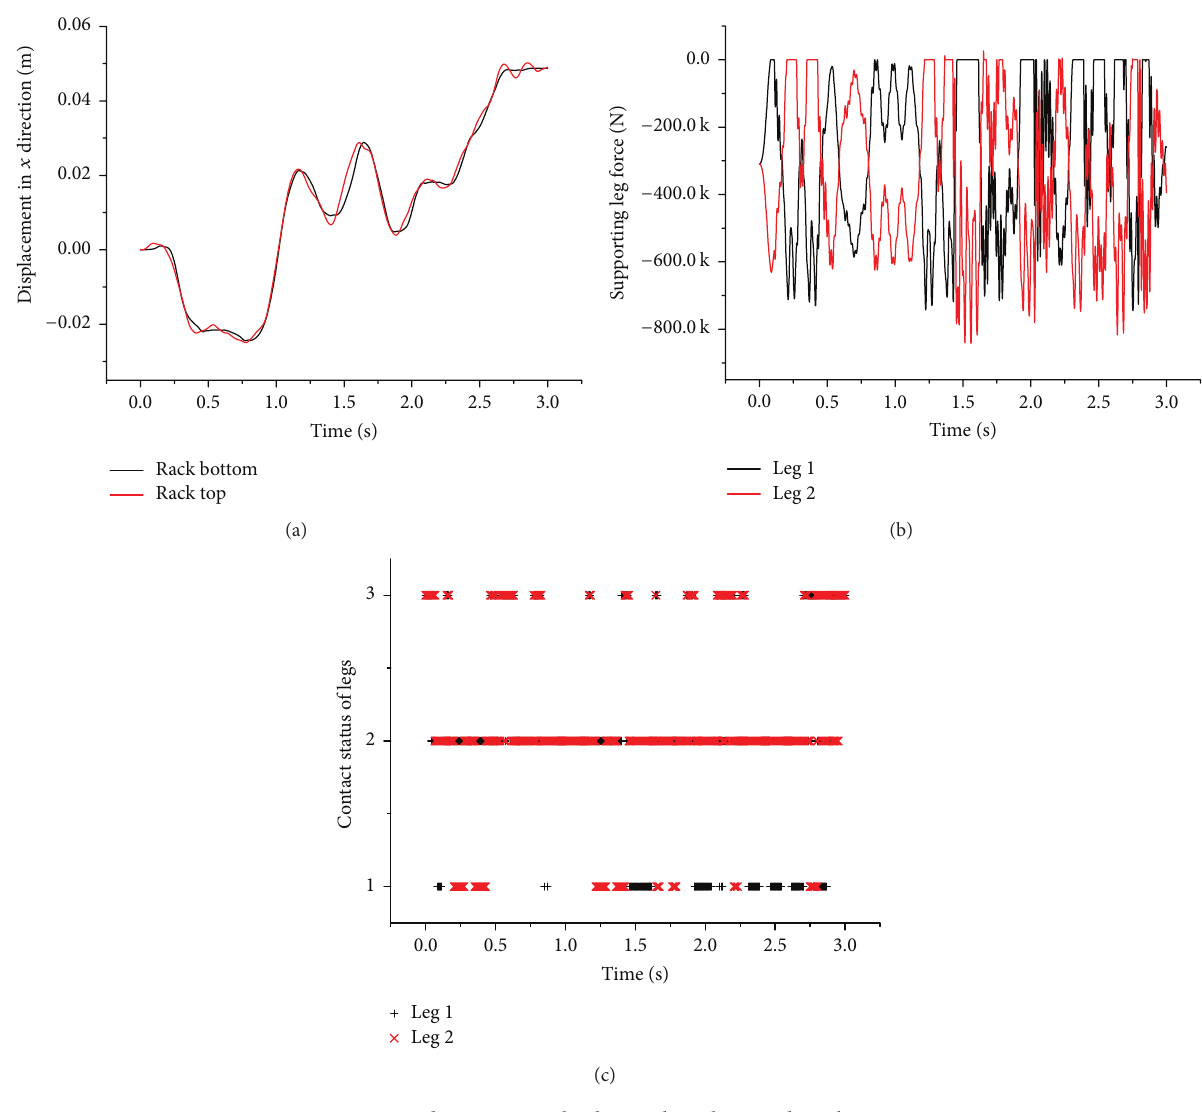
Figure 10: Test Loading 5: seismic loading with peak ground acceleration 0.40 g.